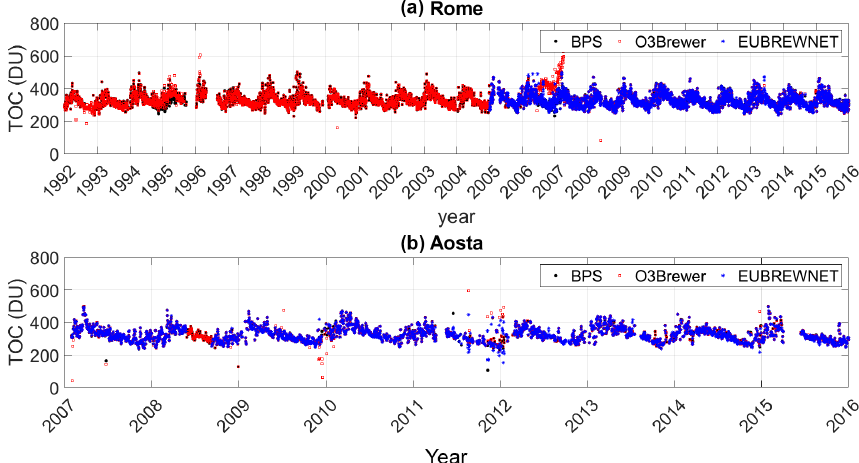
Figure 1. Time series of TOC daily means from BPS (black), O3Brewer (red) and EUBREWNET (blue) at Rome (a) and at Aosta (b) . At Aosta the EUBREWNET level 1.5 ozone values were not generated between 24 May and 8 September 2008, because the standard lamp burnt out in May 2008 and was replaced in September 2008.